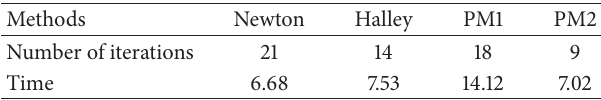
Table 2: Results of comparisons for Example 3. Methods Newton Halley M4 PM2 Number of iterations